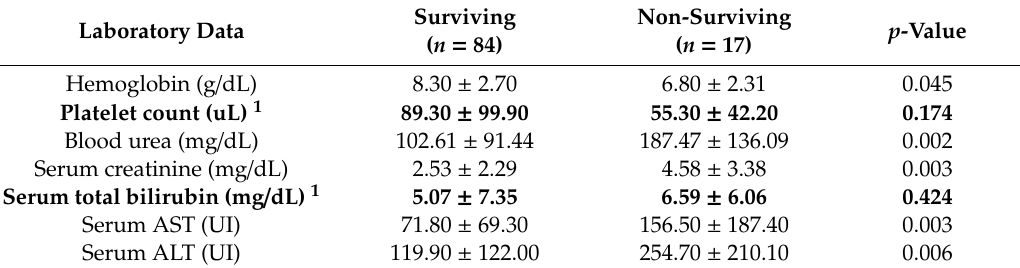
Table 2. ANOVA analysis of laboratory data of patients with severe malaria admitted to the ICU of a hospital in Luanda, Angola.